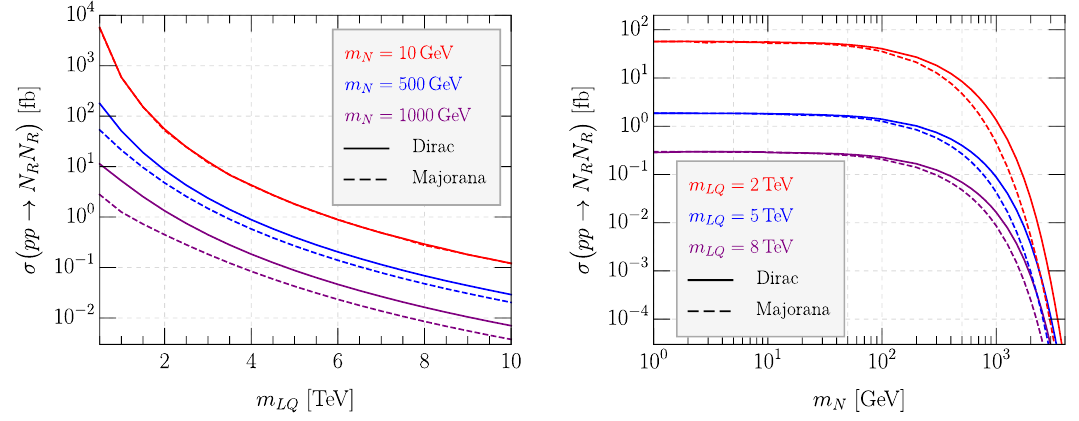
Figure 2 . Cross sections for pair production of HNLs N R as function of m LQ (left) and m N (right). The plots compare the calculation for HNLs which are Dirac particles to the one for Majorana HNLs. √ Only g dN = 2 for first generation was chosen to be non-zero in this example. Majorana N R cross sections are suppressed for m N & 100 GeV, see